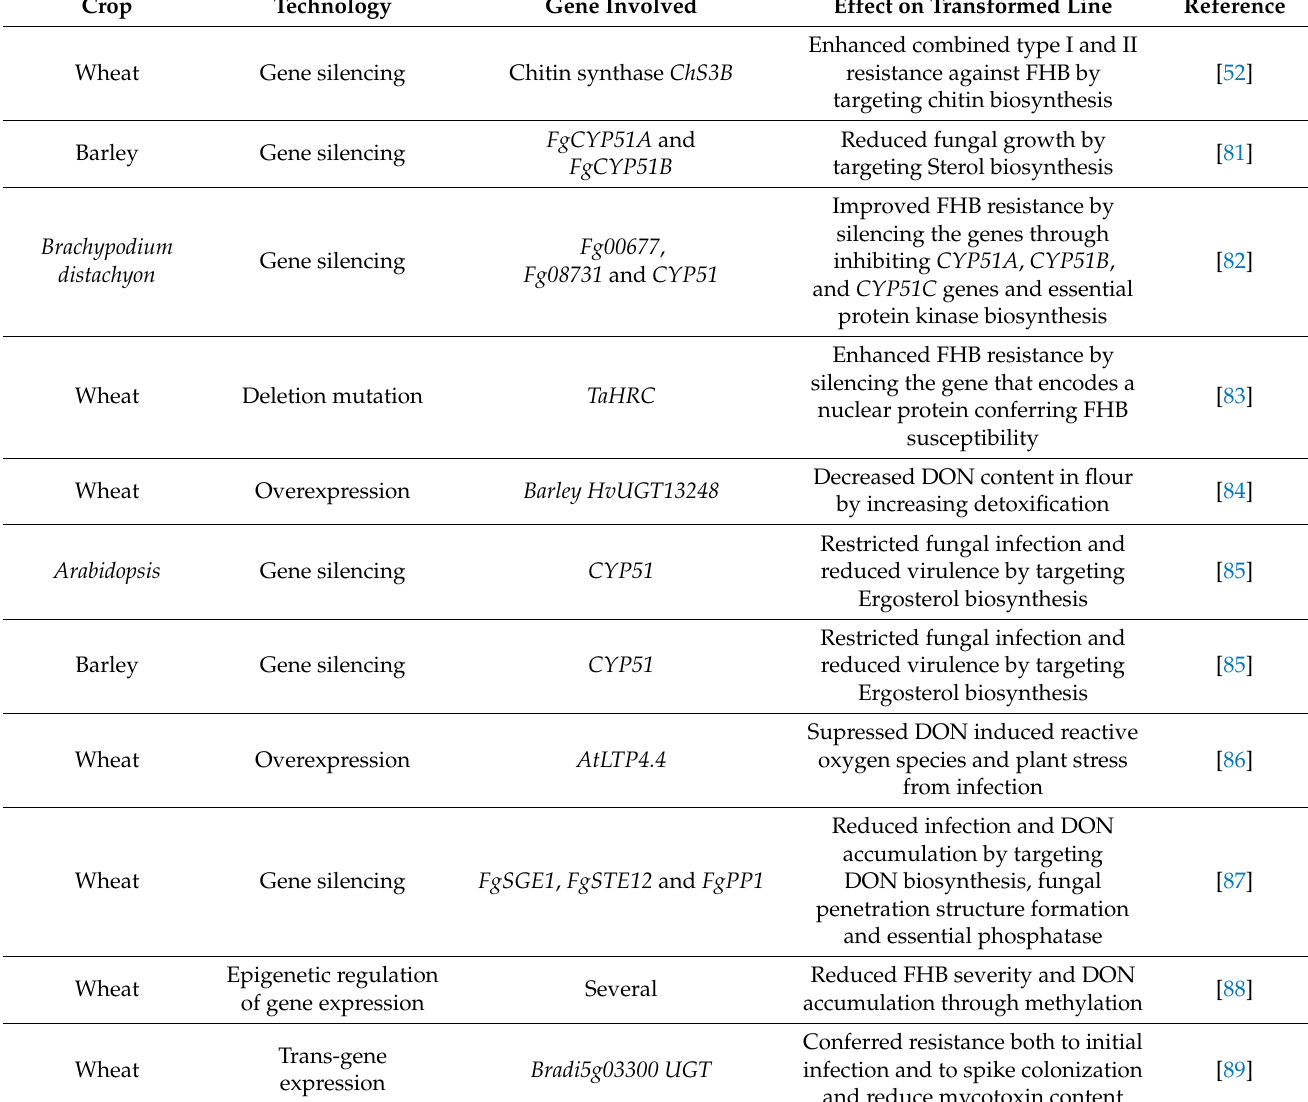
Table 1. Genetic transformation to enhance resistance against Fusarium graminearum causing Fusarium head blight in wheat and other